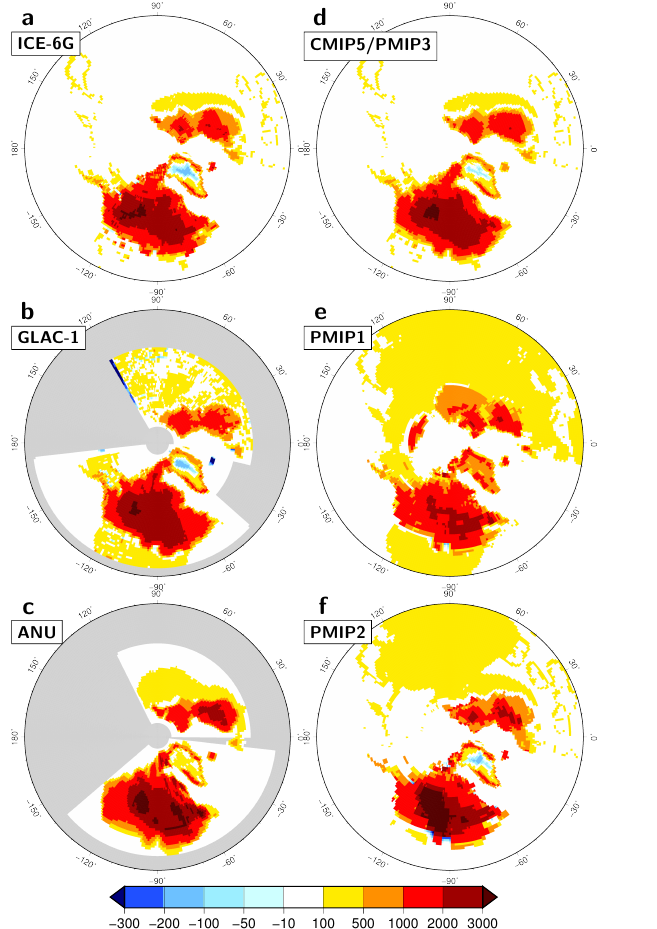
Figure 3. Surface elevation (m) of Antarctica at the LGM from the (a) ICE-6G v.2, (b) ANU reconstructions, and for (c) the CMIP5/PMIP3 composite compared to the ice sheets used in (d) PMIP1 and (e) PMIP2. The GLAC-1a reconstruction for Antarc- tica is identical to that of ICE-6G, and is therefore not